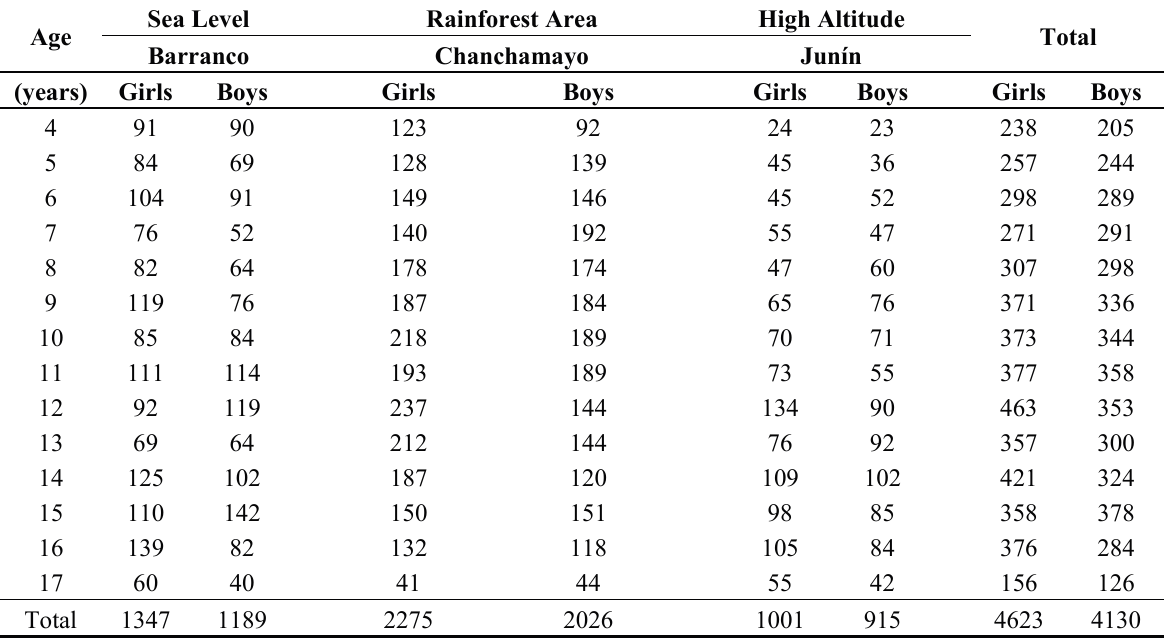
Table 2. Number of school children in the three areas of central Peru according to age and